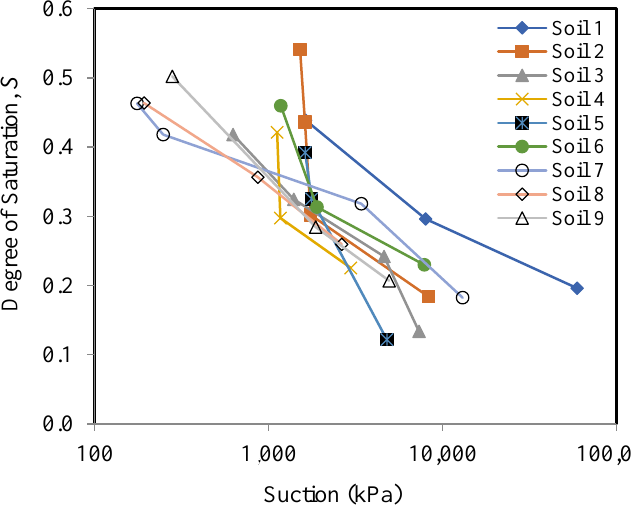
Figure 3. SWCC of soils from 9 landslide sites.